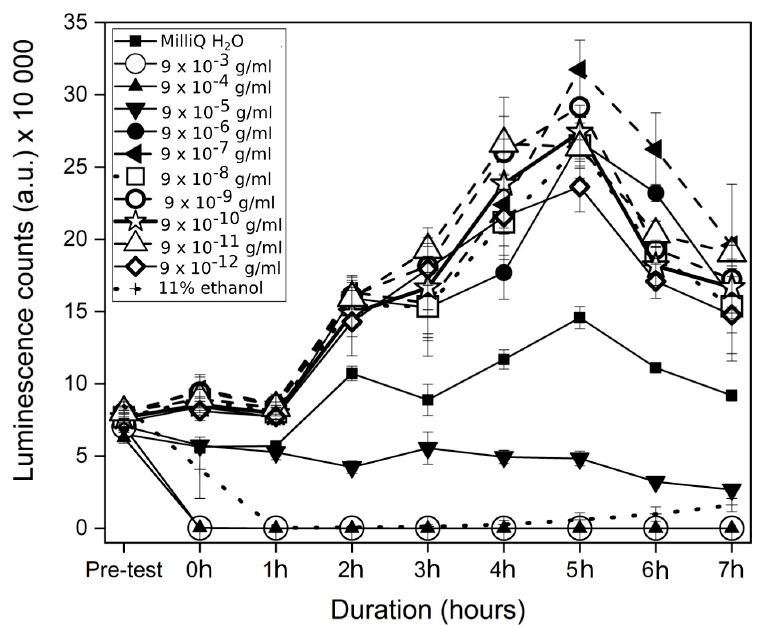
Figure 1. Luminescent counts (mean ± SD) of XEN43 bacteria in the investigated samples over the 7 h testing time.